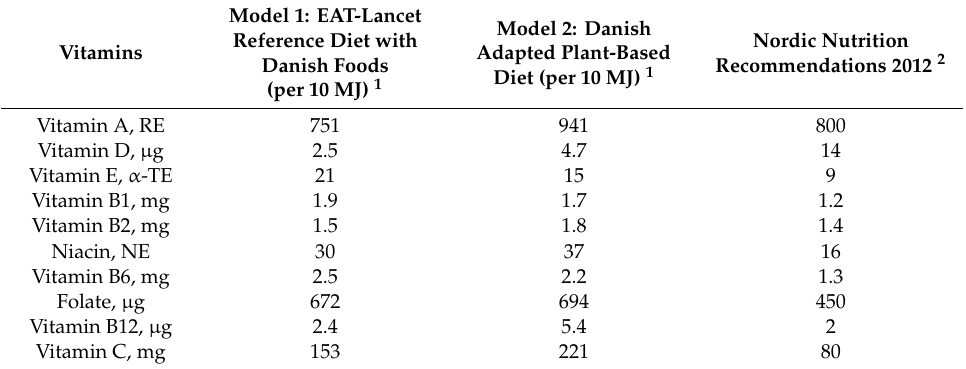
Table 3. Content of vitamins in the EAT-Lancet reference diet with Danish foods (Model 1) and in the Danish adapted plant-based diet (Model 2) per 10 MJ compared to the Nordic Nutrition Recommendations on nutrient